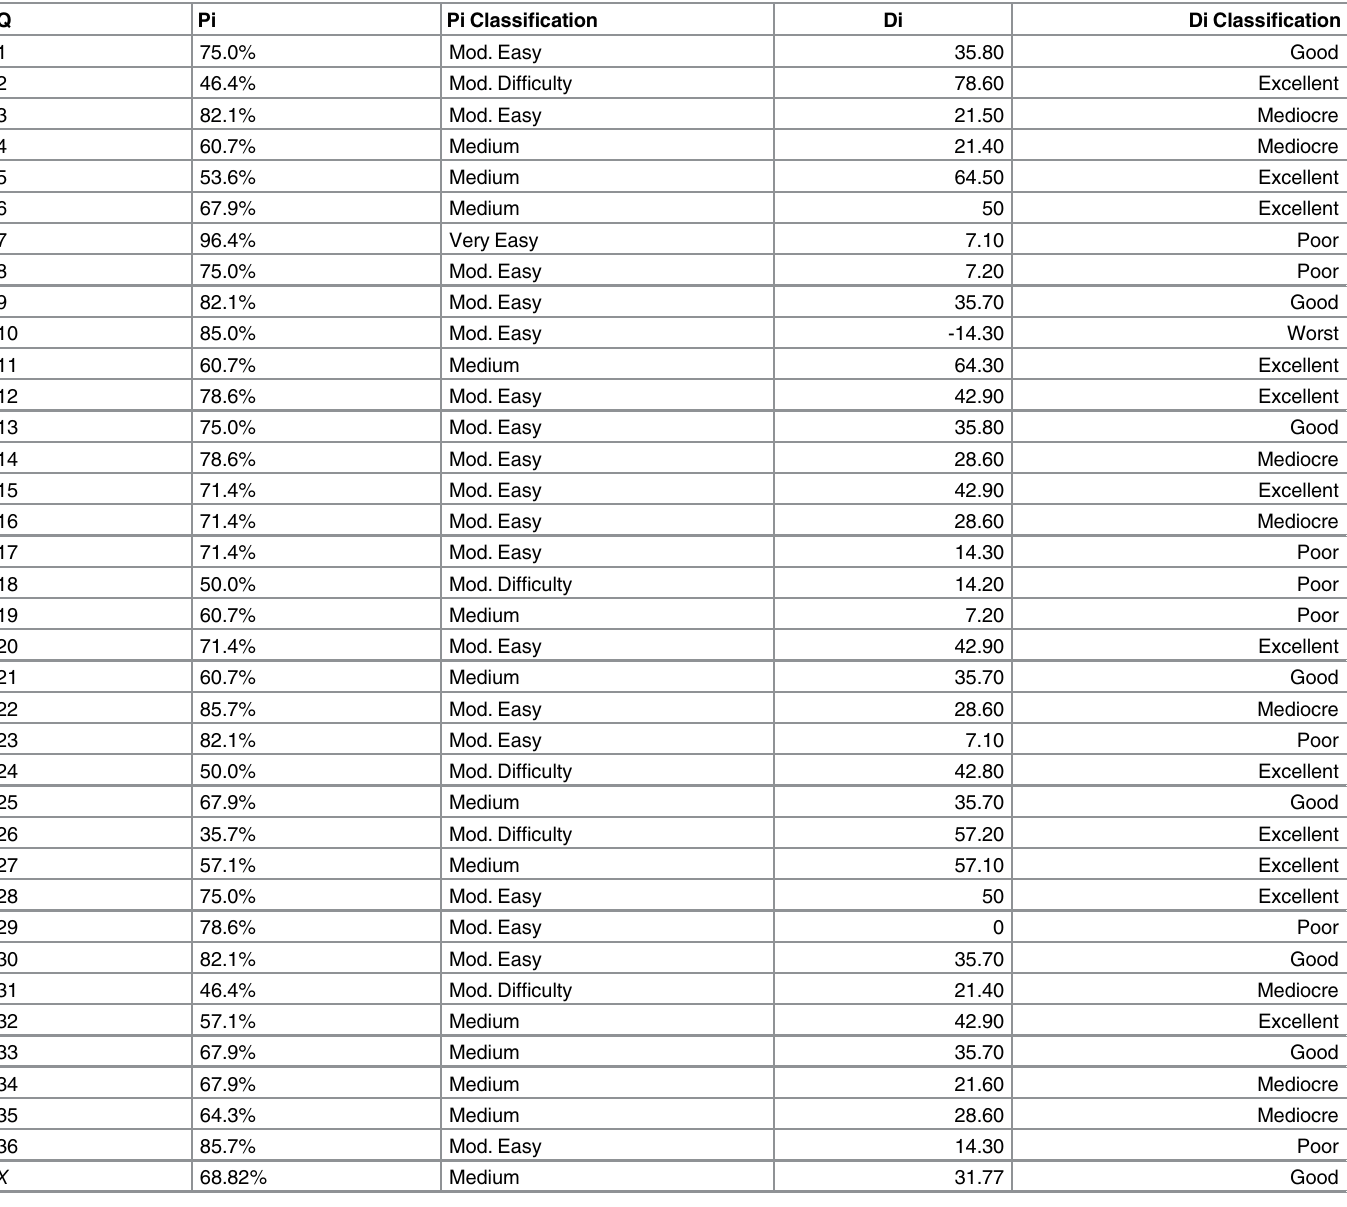
Table 2. Control Difficulty and Discriminatory